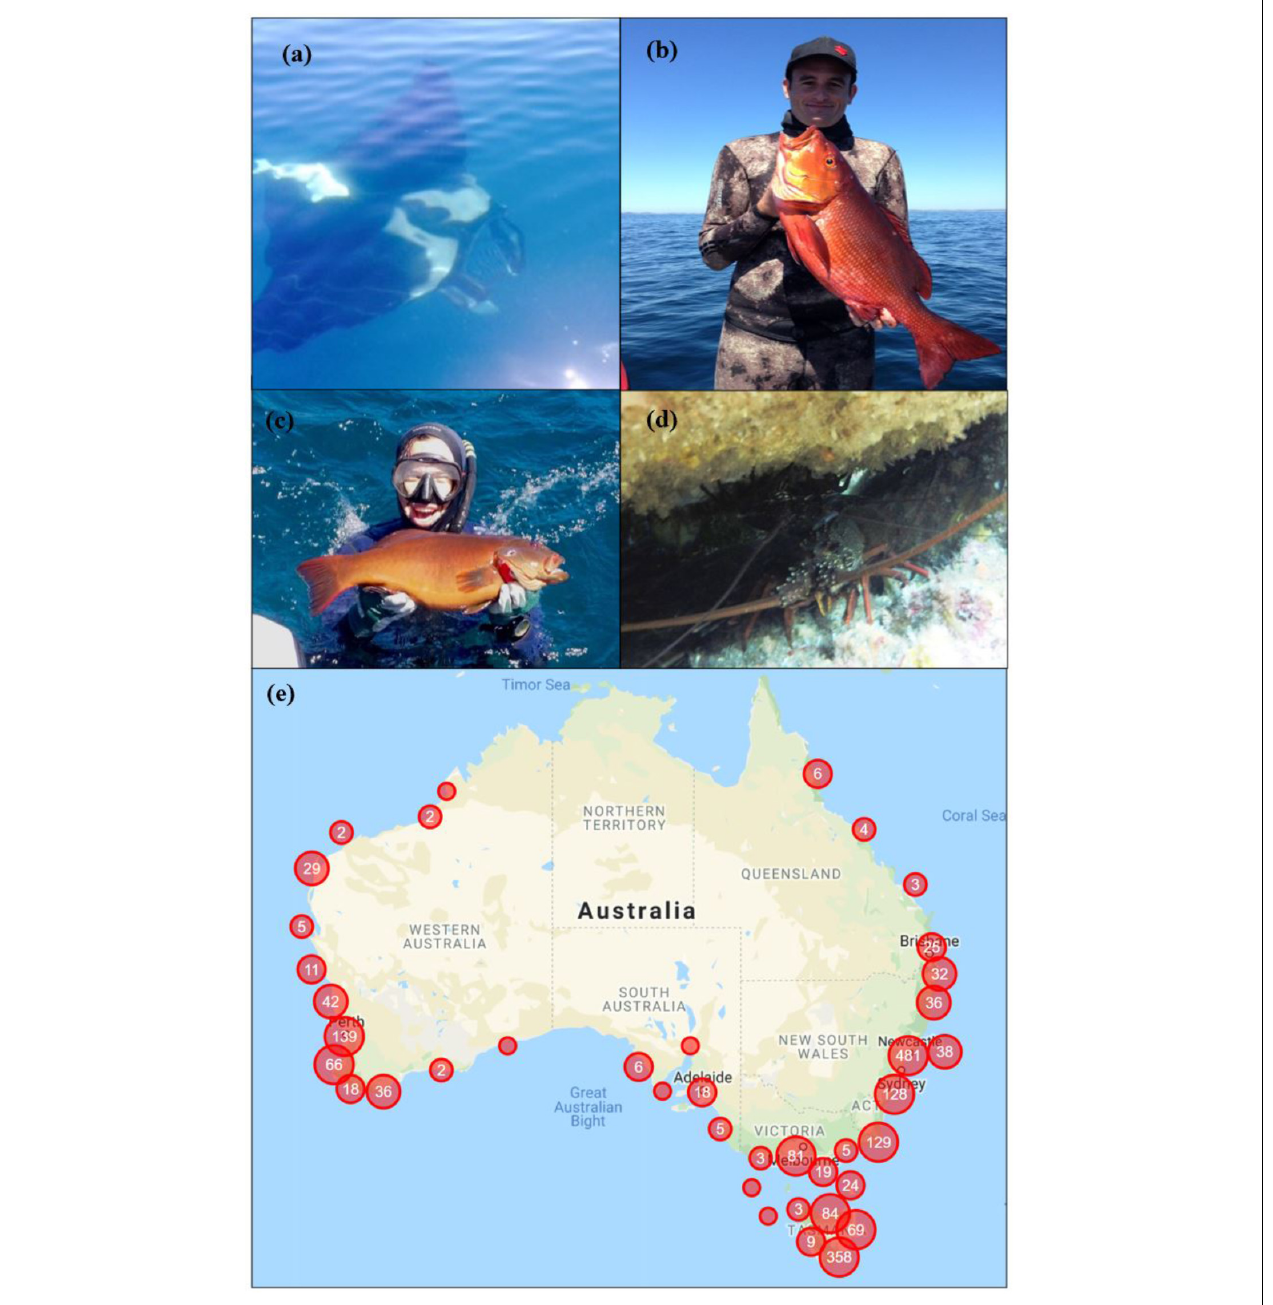
FIGURE 4 | Observations of species reported outside of their known range by Redmap contributors: (a) Manta ray, Manta birostris , reported in north–east Tasmania (www.redmap.org.au/sightings/1191/) by Leo Miller. This is thought to be Australia’s southernmost observation of the species, with the next most southerly observation just south of Sydney (Couturier et al., 2015, Photograph: Leo Miller). (b) Red bass, Lutjanus bohar , caught off Newcastle NSW (www.redmap.org.au/ sightings/1628/). In Australia this species in known to occur in Western Australia, and on the east coast from the Great Barrier Reef to southern Queensland (Photograph: Kylie Johnston). (c) Coral trout, Plectropomus leopardus , caught off Sydney (www.redmap.org.au/sightings/1624/). In Australia its distribution occurs from north-western Western Australia, around the north of Australia to the southern end of the Great Barrier Reef, in Queensland on the east coast (Photograph: Derrick Oscar Cruz). (d) A den of eastern rock lobster, Sagmariasus verreauxi , photographed at St Helens off eastern Tasmania (www.redmap.org.au/region/tas/ sightings/1238/). This species is more common to New South Wales but is observed or captured occasionally along the north coast of Tasmania in small numbers. Larvae are thought to be delivered into Tasmanian waters via the East Australian Current (Photograph: John Keane). (e) Locations of observations submitted to Redmap by citizen scientists over the duration of the program. Numbers within the red circles indicate the number of discrete observations submitted for that area. People depicted within the images gave their written informed consent for the photographs to be included.